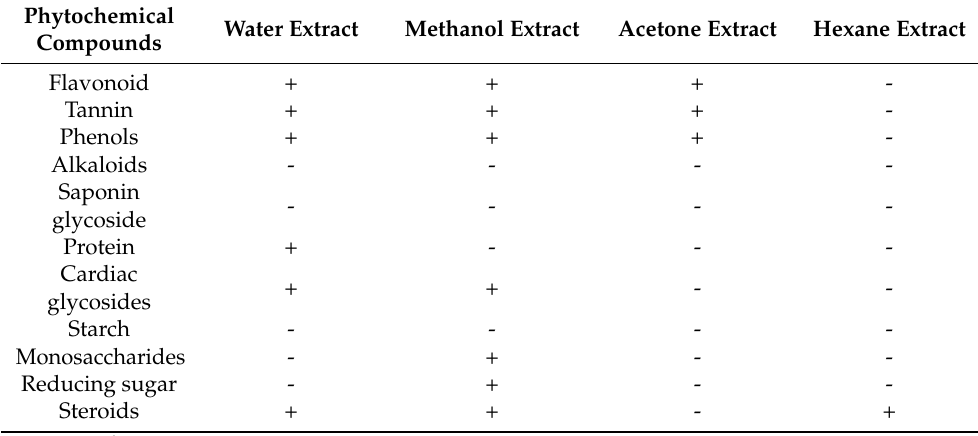
Table 1. Identification tests results of H. lanuginosum extracts. Phytochemical Water Extract Methanol Extract Acetone Extract Hexane Extract Compounds Flavonoid + + + - Tannin + + + - Phenols + + + - Alkaloids - - - - Saponin - - - glycoside Protein + - - - Cardiac + + - - glycosides Starch - - - - Monosaccharides - + - - Reducing sugar - + - - Steroids